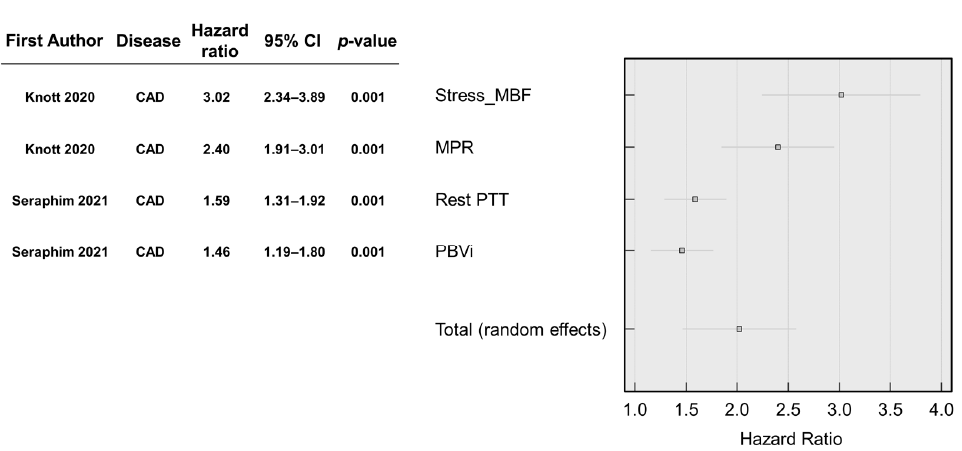
Figure 3. A forest plot of AI using CMR parameters and their significance for automated perfusion quantification in patients with coronary artery disease [13,14]. Abbreviations: CAD, coronary artery disease; MBF, myocardial blood flow; MPR, myocardial perfusion reserve; PTT, pulmonary transit time; PBVi, pulmonary blood volume index.